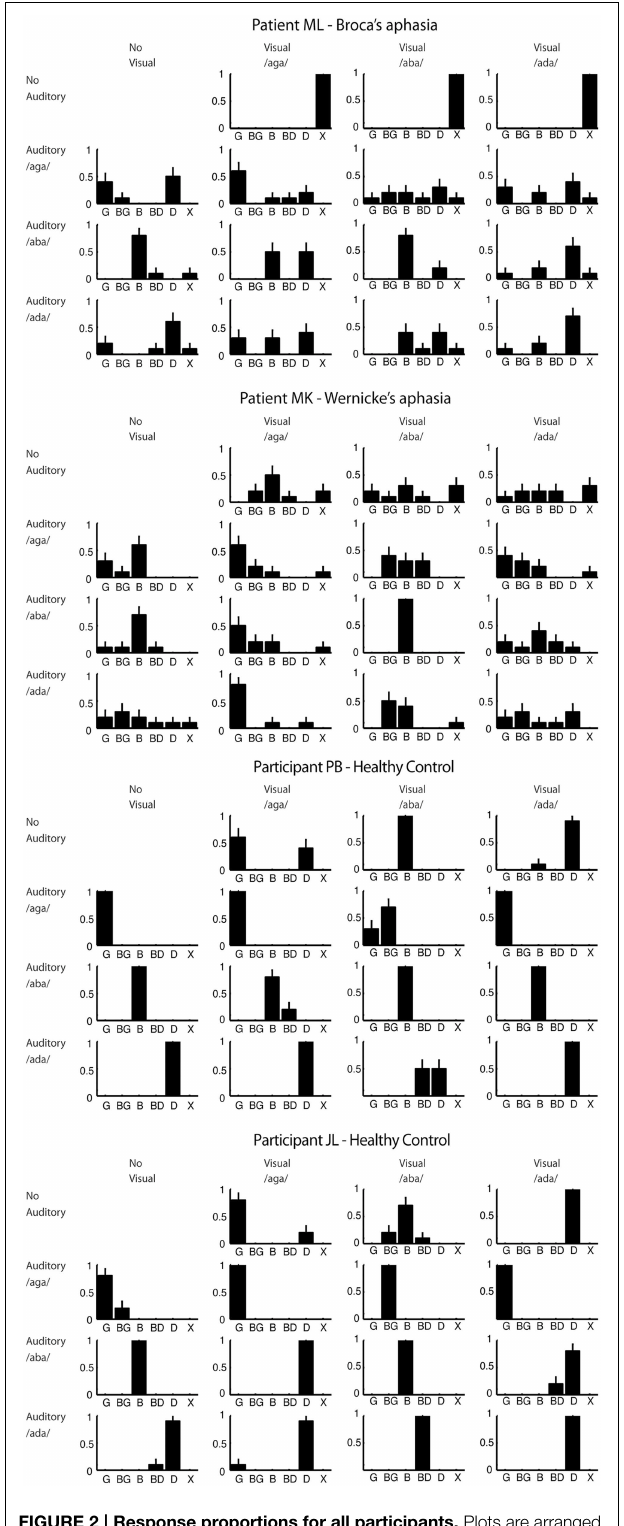
FIGURE 2 | Response proportions for all participants. Plots are arranged in rows and columns according to the visual and auditory component of the stimulus respectively. The response category “X” corresponds to no answer. Error bars show the multinomial standard